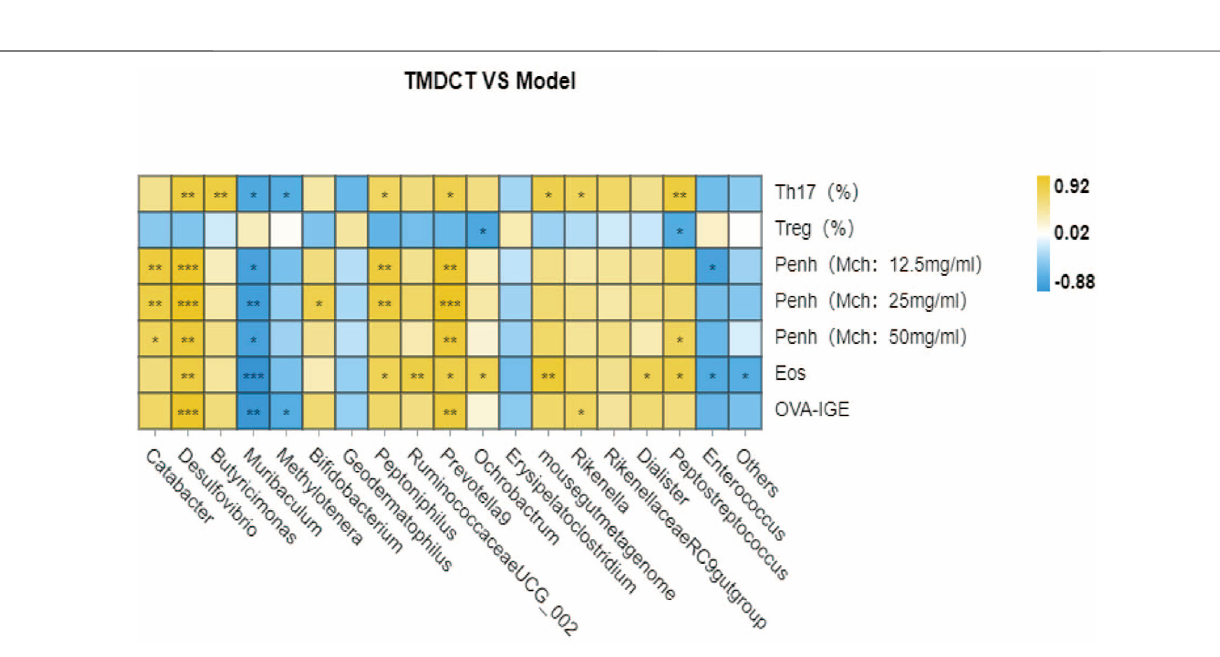
Frontiers in Pharmacology |